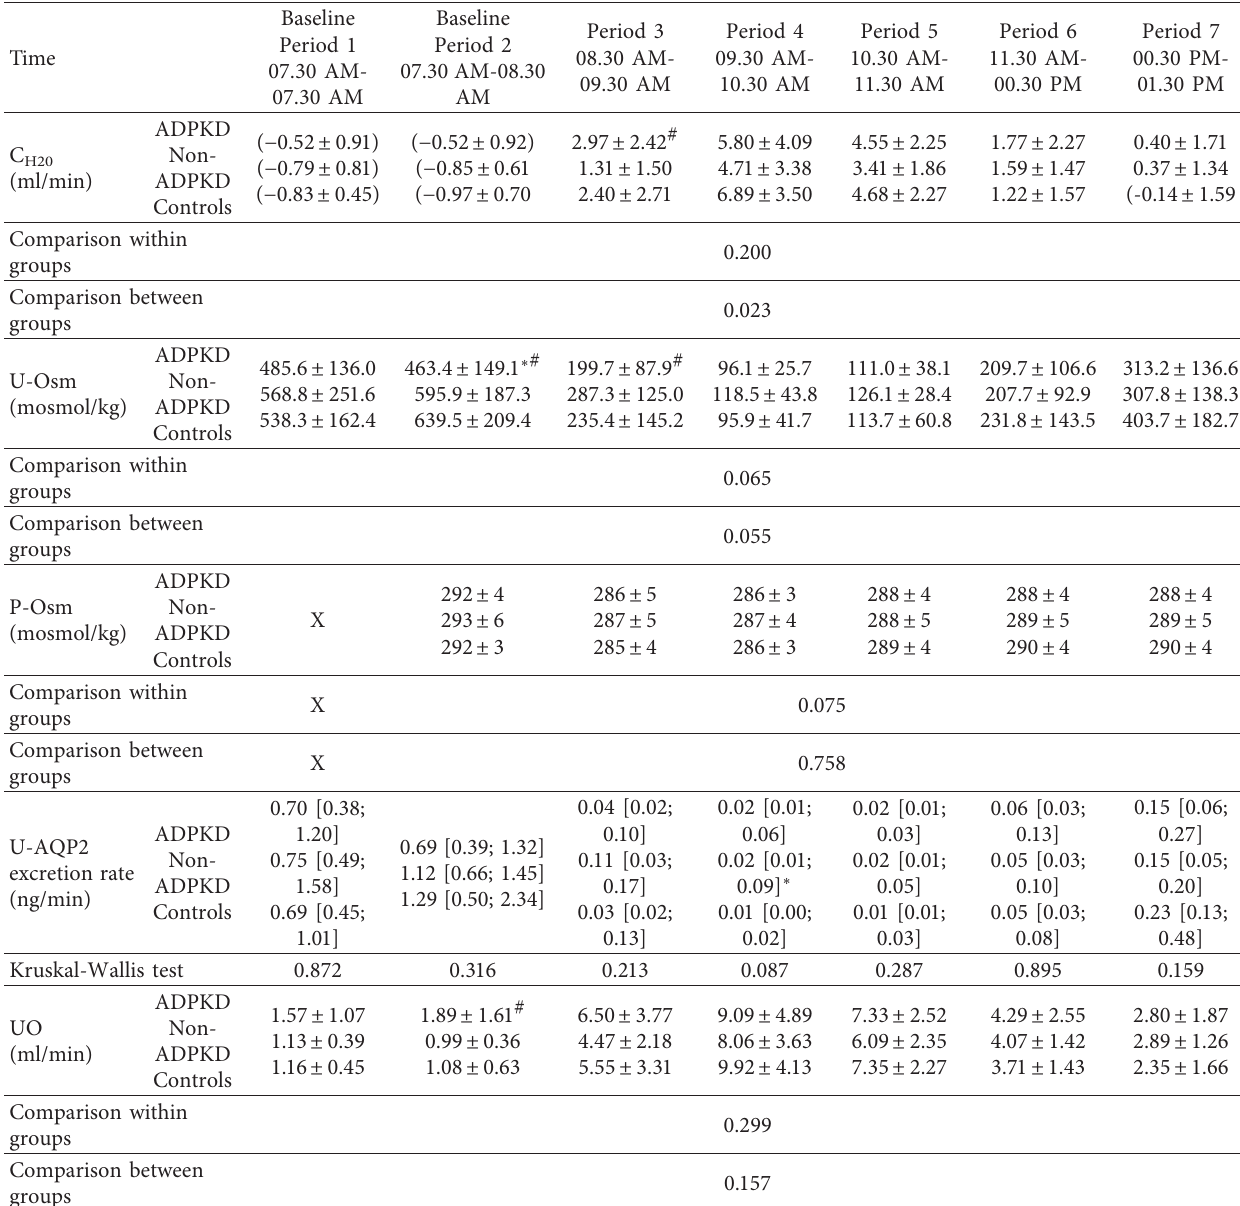
Table 2: Renal water excretion during the water loading test in patients with adult dominant polycystic kidney disease (ADPKD), patients with non-ADPKD kidney disease (non-ADPKD), and healthy control subjects